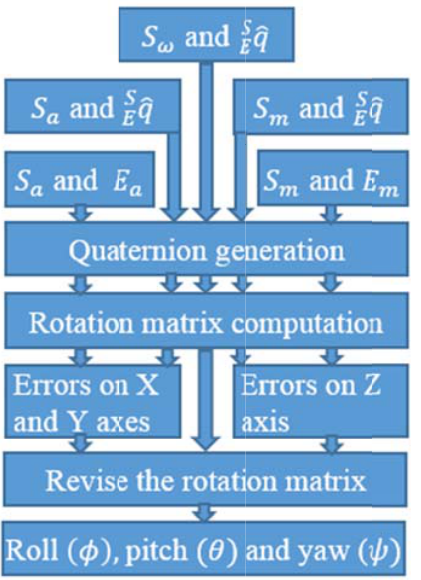
Figure 8. T eration